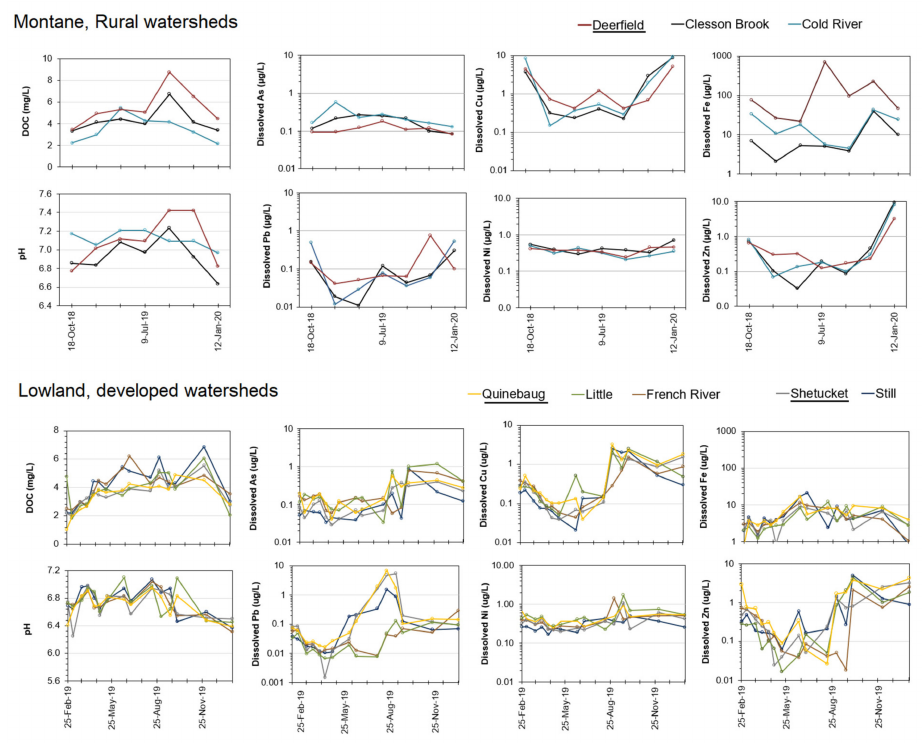
Figure 3. River water pH, DOC, and dissolved trace element concentrations in the montane, Deerfield watersheds of northwestern Massachusetts and in the lowland, Quinebaug and Shetucket watersheds of eastern Connecticut. Please note the different collection dates and linear scale for DOC. River water samples were filtered to < 0.45 µ m.